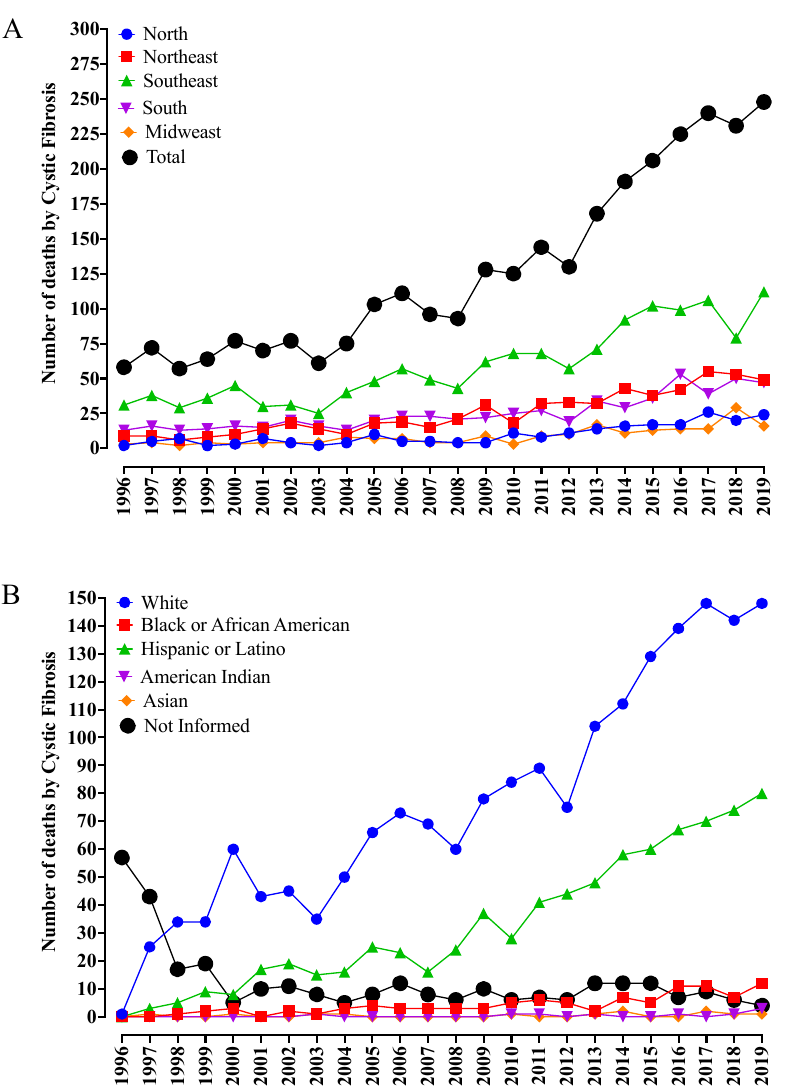
Figure 1. Number of deaths from cystic fibrosis (CF) in Brazil from 1996 to 2019 according to the Brazilian region (Figure 1A) and racial group (Figure 1B). ( A ) In 1996, the Southeast (the most populated Brazilian region) presented 31 reported deaths from CF. In 2019, the number increased from 31 to 112 cases, totaling 1418 deaths, with an increase of 3.6 times. The South region presented 13 deaths in 1996. This number rose to 47 in 2019, representing an increase of 3.6 times and totaling 604 deaths. The Northeast region had nine deaths in 1996, rising to 49 in 2019, demonstrating an increase of 5.4 times and 597 deaths. Finally, in 1996, the North region presented two deaths from CF, while the Midwest had three, which increased to 24 and 16, respectively, in 2019. This shows a 12-fold increase, totaling 228 deaths in the North region, while the Midwest region presented a 5.3-fold increase and 203 deaths. ( B ) Only one death from CF in the White group was recorded in 1996. In 2019, however, this number increased to 148. During this period, 1843 deaths were reported. No Hispanic or Latino, Black or African American, American Indian, or Asian individual died due to CF in 1996. On the other hand, in 2019, 80 deaths were reported in the Hispanic or Latino racial group, totaling 787 cases in the period analyzed; 12 in the Black or African American group, reaching 99 deaths; three in the American Indian group, totaling nine cases, and one in the Asian group, totaling 12 deaths. In addition to these cases, the Data-SUS death registers recorded deaths under the classification ‘not informed’. Within that group, 57 cases were reported in 1996 and only four cases in 2019, totaling 300